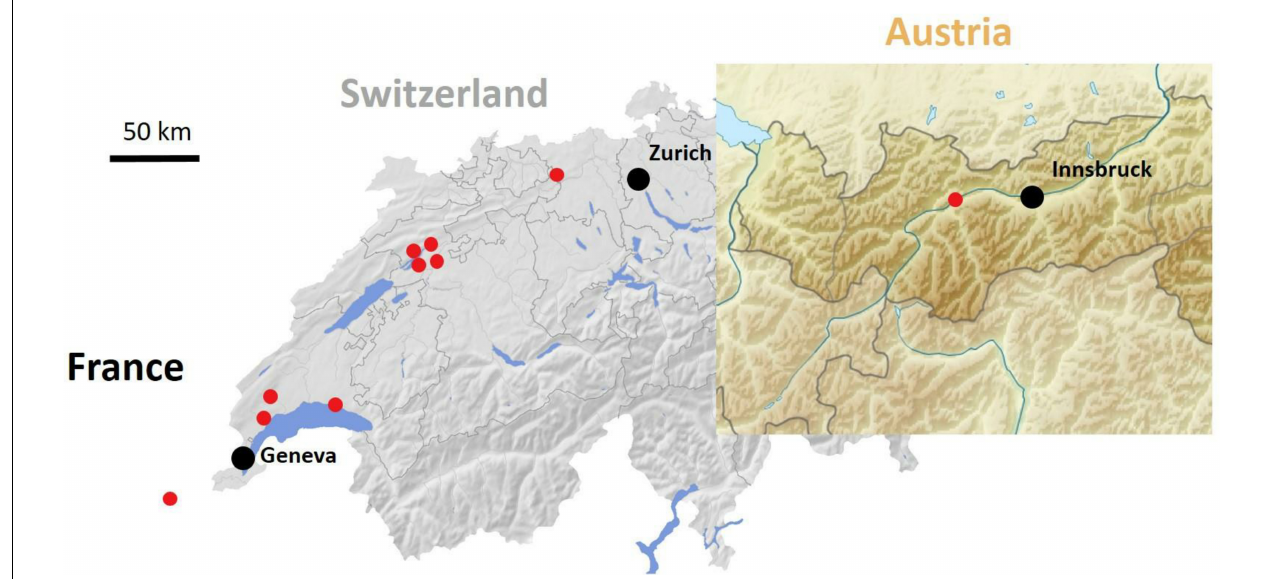
FIGURE 8 | Geographic distribution of ligustrum mosaic virus (LigMV) in Switzerland and its neighboring countries. Red circles represent sites with at least one LigMV-infected L. vulgare plant.